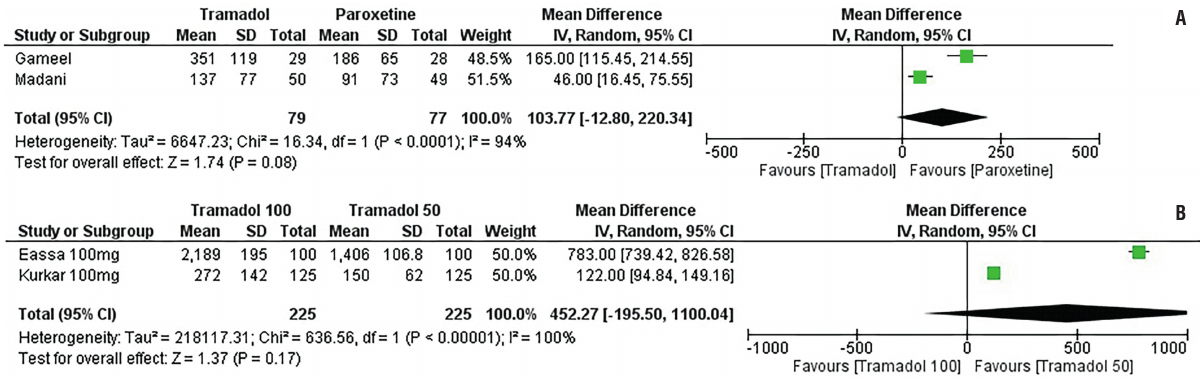
ry outcome across individual studies was